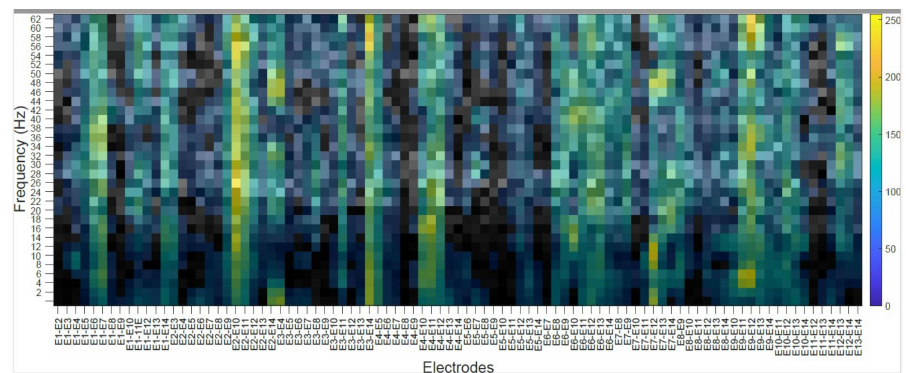
Figure 8. Subject’s Internal representation (CAM) in imagined tasks of the vowel /a/. The horizontal axis represents the difference between electrode and the vertical axis, the corresponding frequencies.